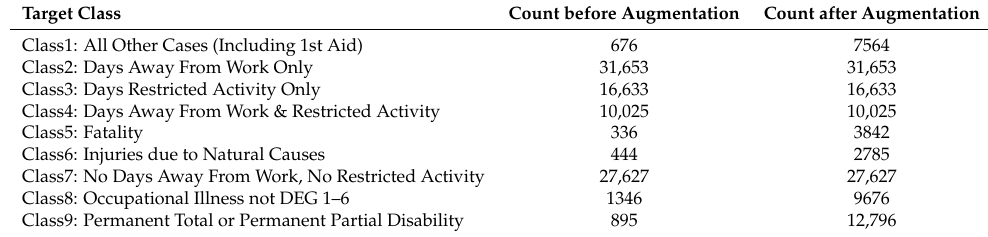
Table 1. Number of records in each target class before and after synthetic